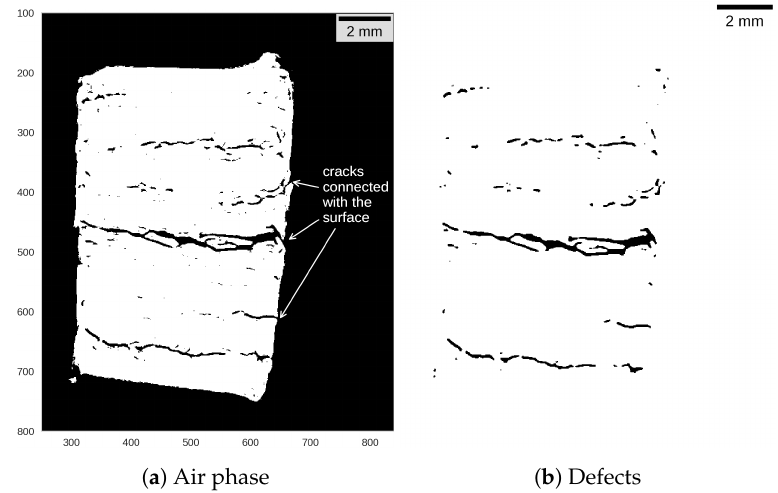
Figure A1. Segmented X-ray tomogram showing ( a ) air phase; ( b ) isolated defects after